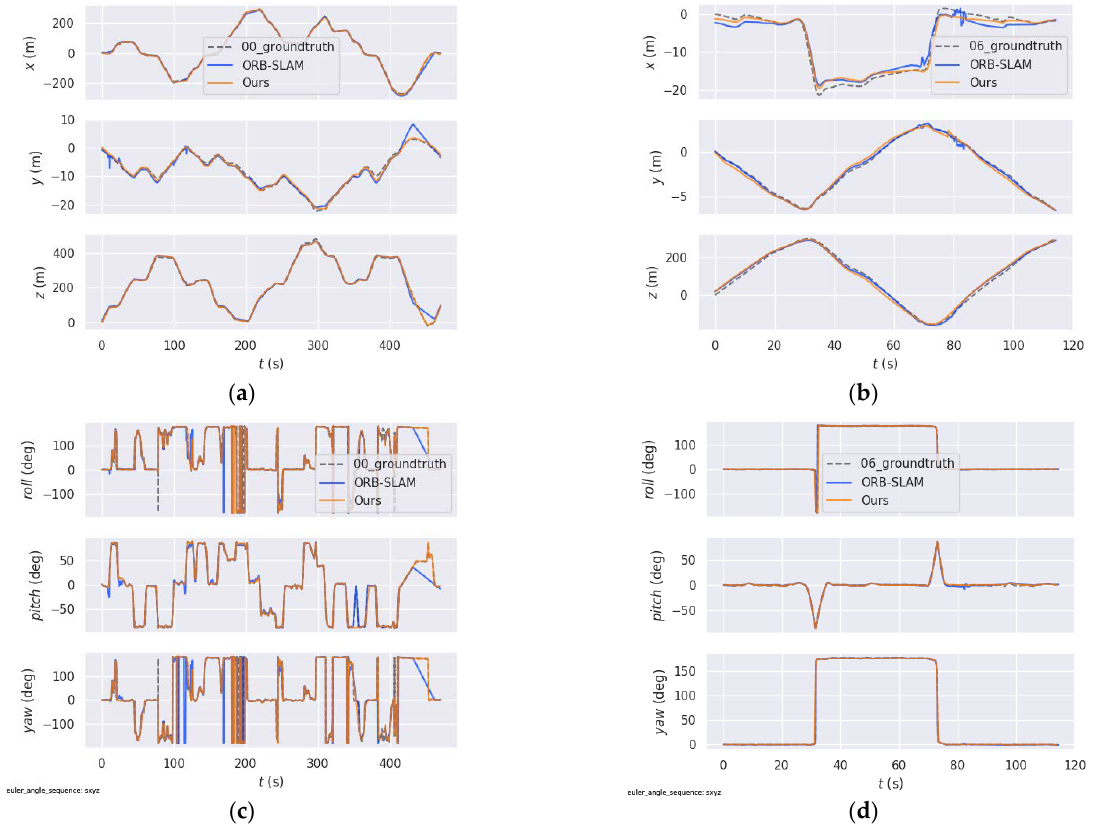
Figure 13. Performance of different algorithms on the different sequences of the KITTI dataset. ( a , b ) are the trajectory errors of different algorithms on the X, Y, and Z axis. ( c , d ) are the trajectory errors of different algorithms on the yaw, pitch, and roll.